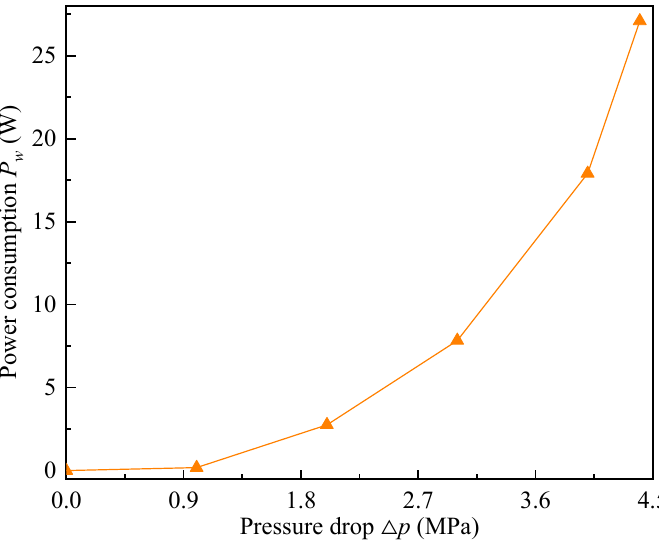
Figure 5. Power consumption of MR valve under different pressure